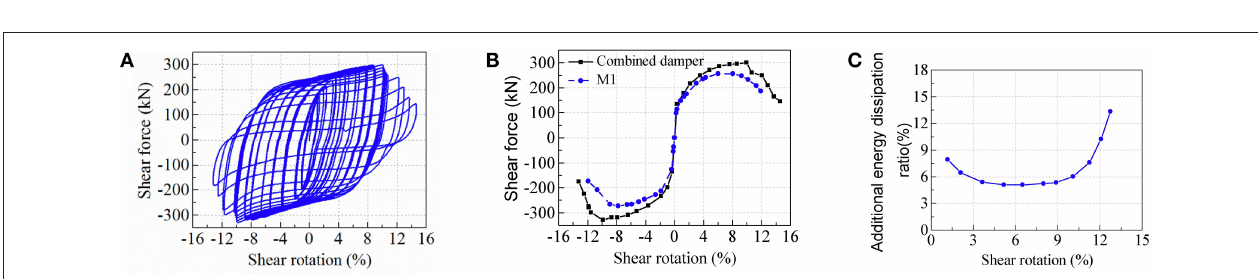
FIGURE 11 | Combined damper: (A) hysteretic curve; (B) skeleton comparison with the metallic damper M1; (C) energy dissipation by VE